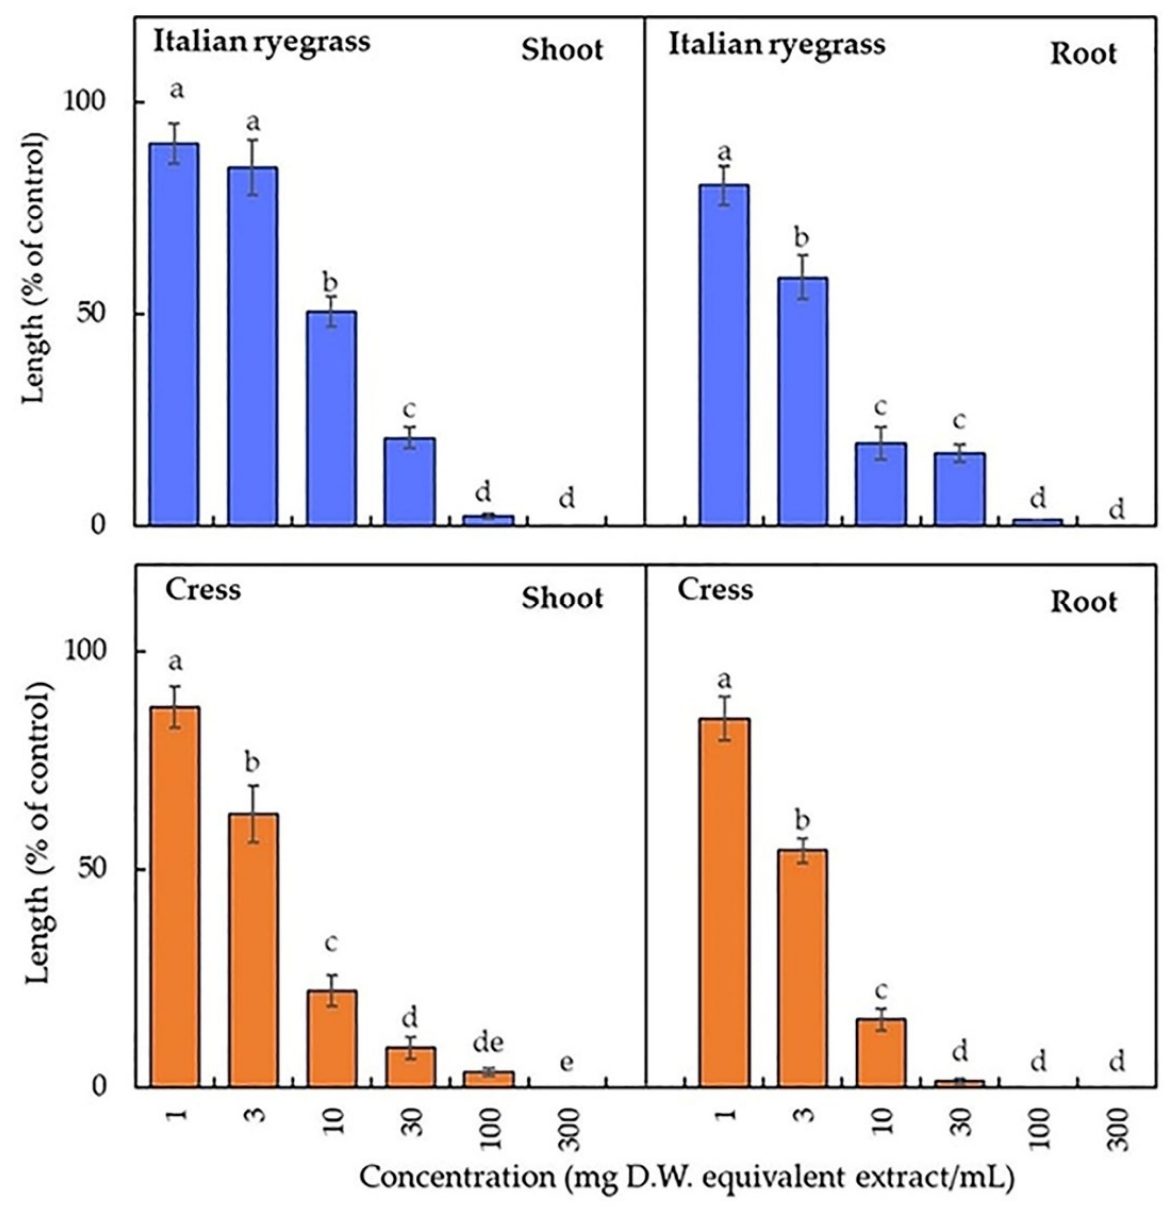
Figure 1. Effect of aqueous methanol extracts of Dregea volubilis leaves on the shoot and root growth of Italian ryegrass and cress. The vertical bars represent the standard error of the mean. Different letters in each category indicate significant differences among the treatments (Tukey’s HSD, p ≤ 0.05).